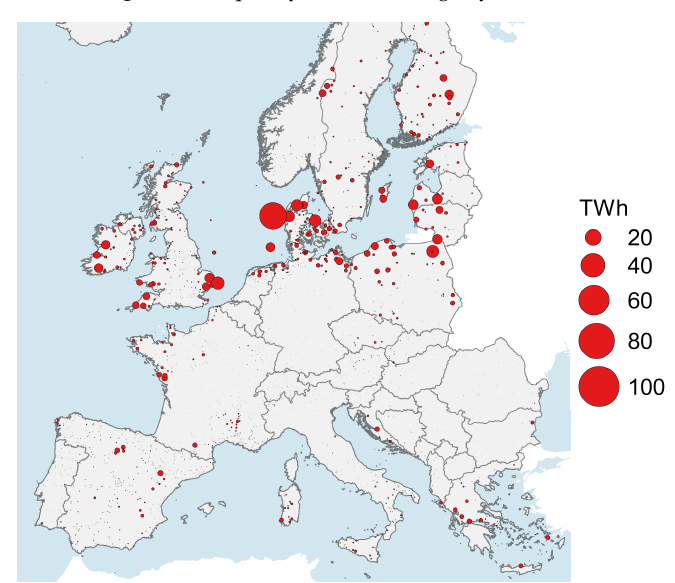
Figure 7. Frequency of line loading beyond 50% of the nominal capacity.